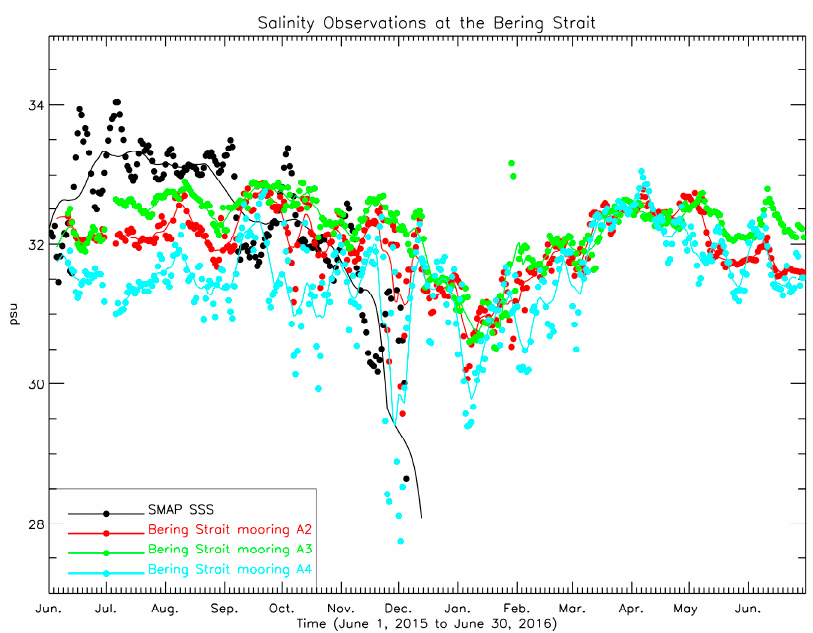
Figure 11. Daily time series of salinity at the Bering Strait retrieved from SMAP (black), and mooring measurement at mooring sites A2 (red), A3 (greed) and A4 (blue). Daily data are indicated by solid dots and lines illustrate the 8 days moving average.